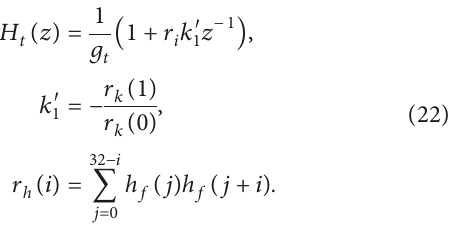
Figure 7: Example of frequency response of short time postfilter. (a) 1/ A (c) Frequency response of spectral tilt compensation. (d) Frequency of short-time